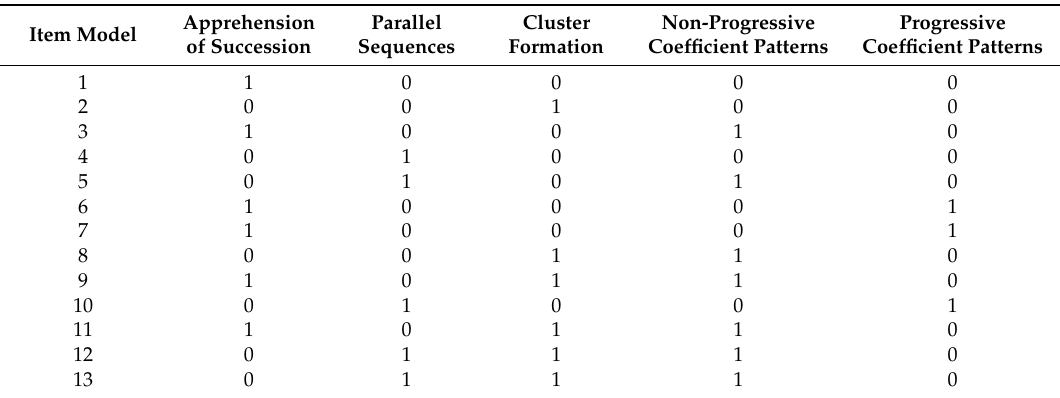
Table 4. Q-matrix of the proposed cognitive operators.